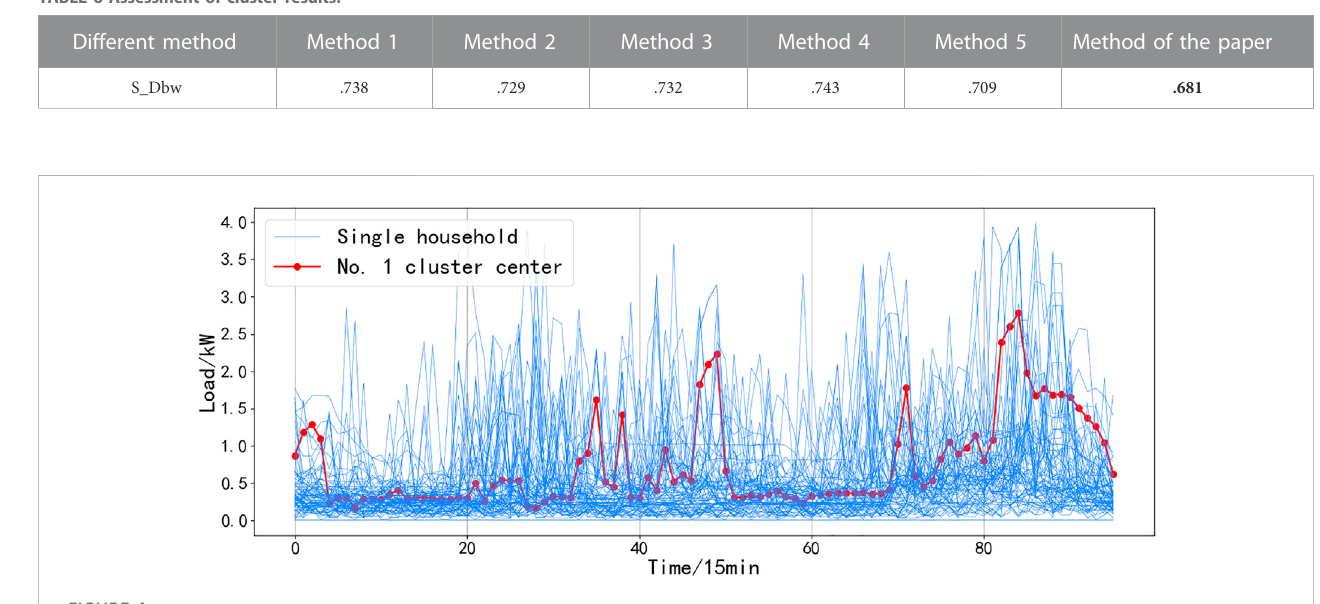
FIGURE 4 Category 1 of residential electricity mode and the clustering center of